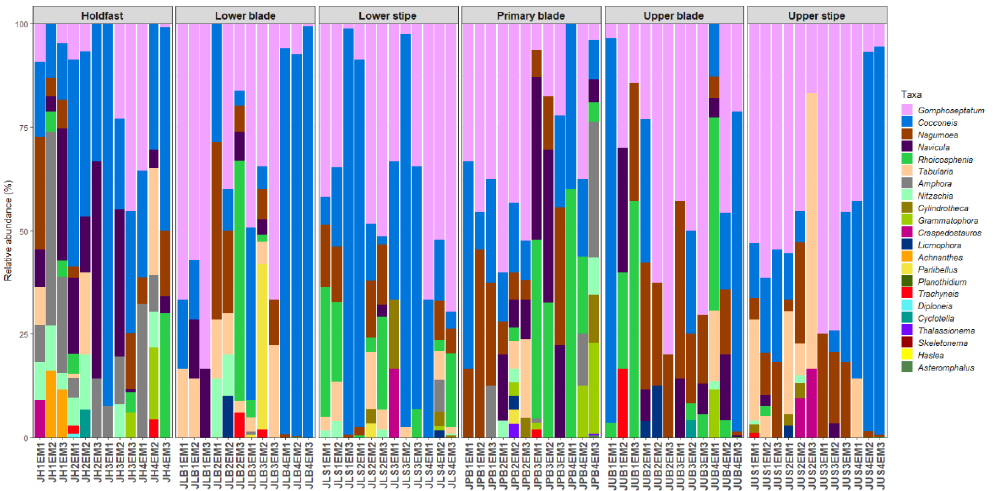
Figure 6. Relative abundance of diatom genera on different parts of juvenile specimens of Ecklonia maxima .